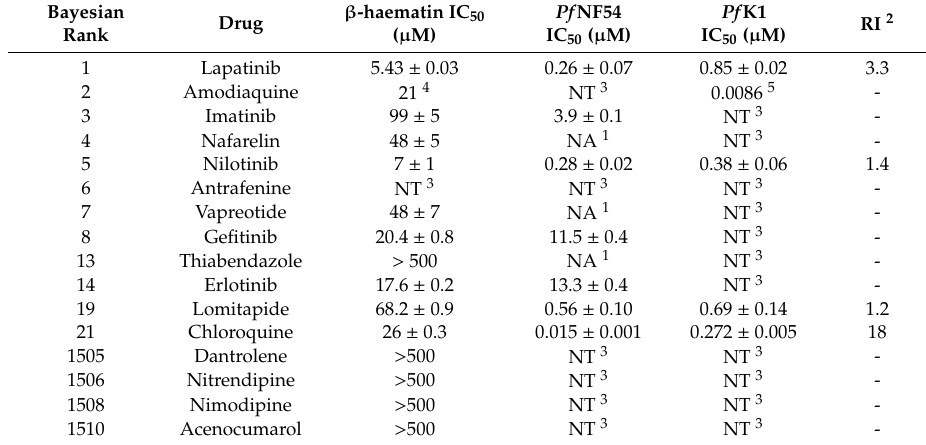
Table 1. Inhibition of β -haematin formation and parasite activity in CQ-sensitive ( Pf NF54) and multidrug-resistant ( Pf K1) strains of P. falciparum of top-ranked USFDA approved drugs selected on the basis of their ranking in a previously published Bayesian model